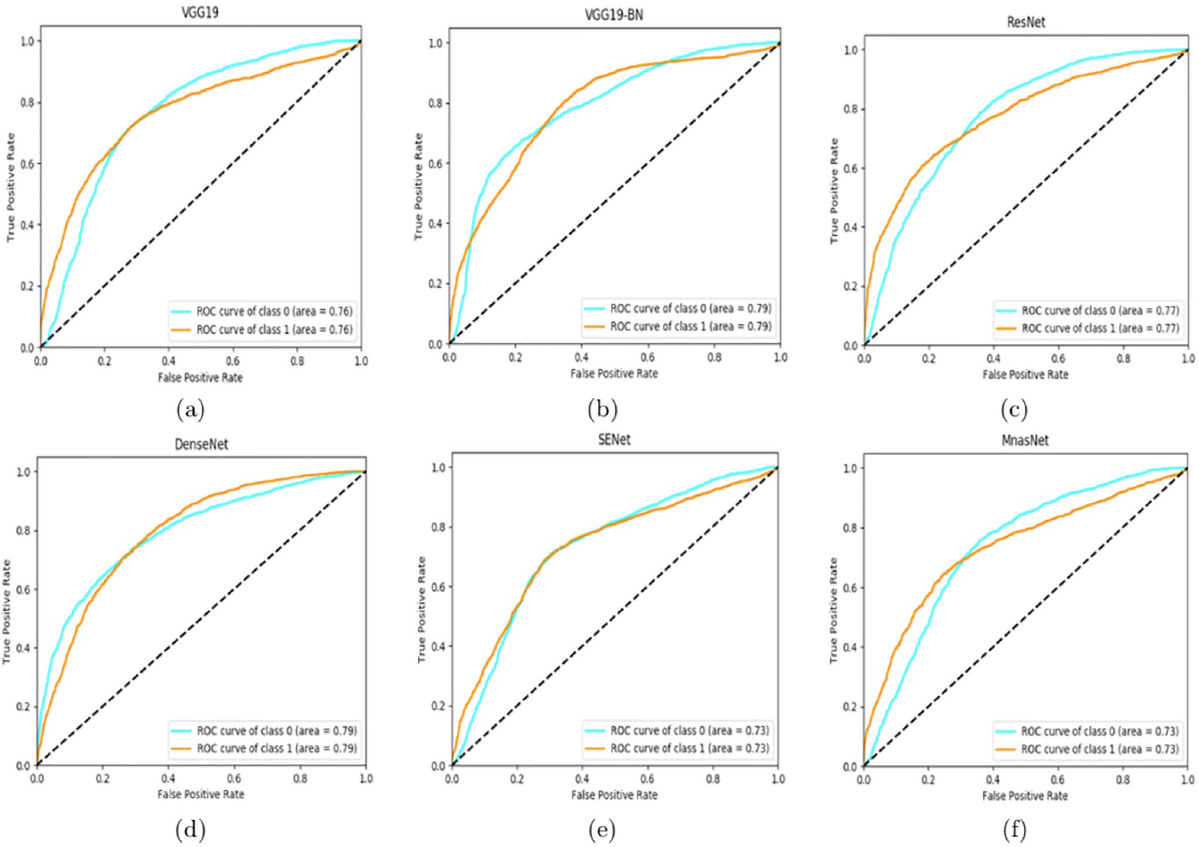
Fig 3. AUC-ROC curves of different models on set-1: (a) VGG19 (b) VGG19-BN (c) ResNet50 (d) DenseNet (e) SENet (f) MnasNet.